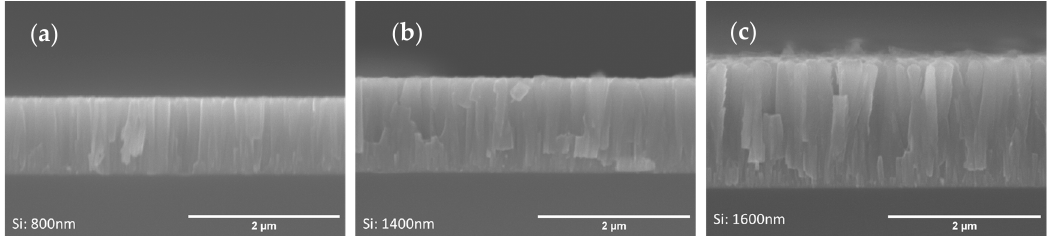
Figure 8. SEM cross-section micrograph images of coatings with different thicknesses deposited on Si: ( a ) 800 nm, ( b ) 1400 nm, and ( c ) 1600 nm.